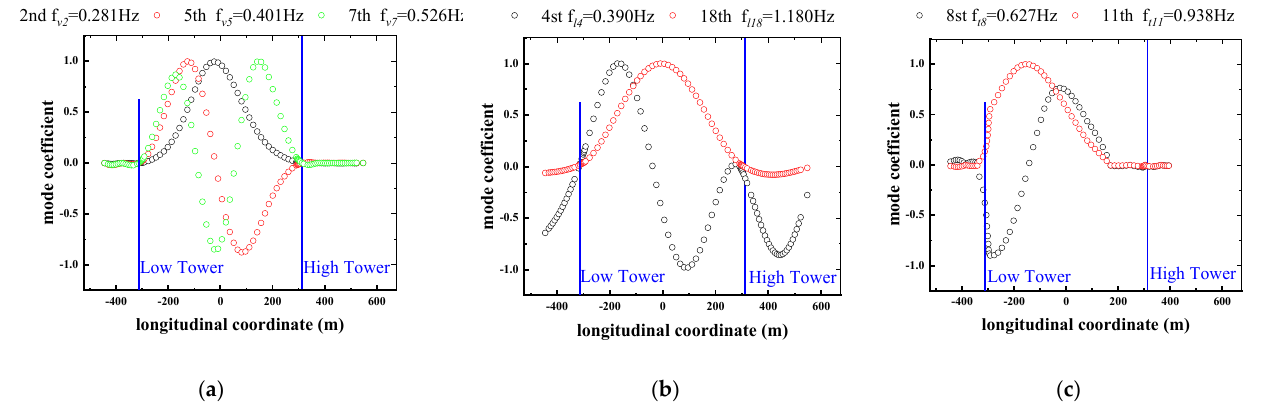
Figure 5. The lateral, vertical, and torsional modes. ( a ) Lateral; ( b ) vertical; ( c ) torsional.